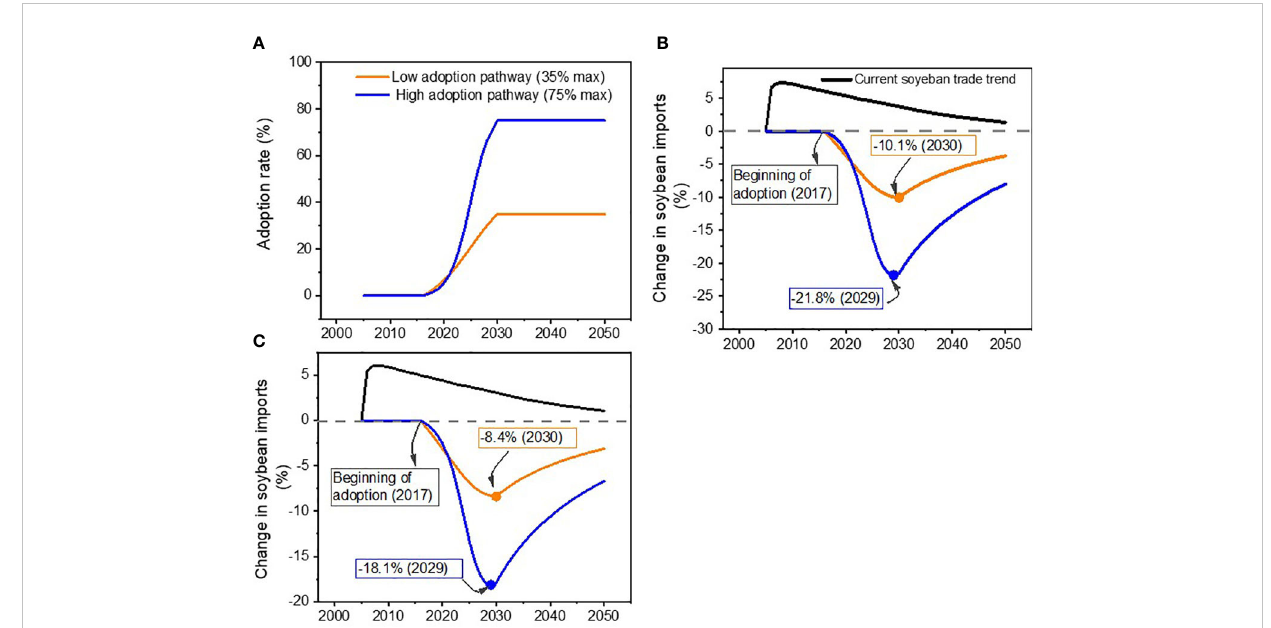
FIGURE 6 Scenario outlooks (2010 – 2050) of adoption of the combined rhizobia and phosphorus fertilizers technology based on average yield increase by 133.7% from the Nigeria savannas and by 111% in the Northern Guinea Savanna on-farm demonstrations plots (A) adoption pro fi le by 35% and by 75% with with projectd impact under scenario, (B) for all sample sets and (C) Northern Guinea